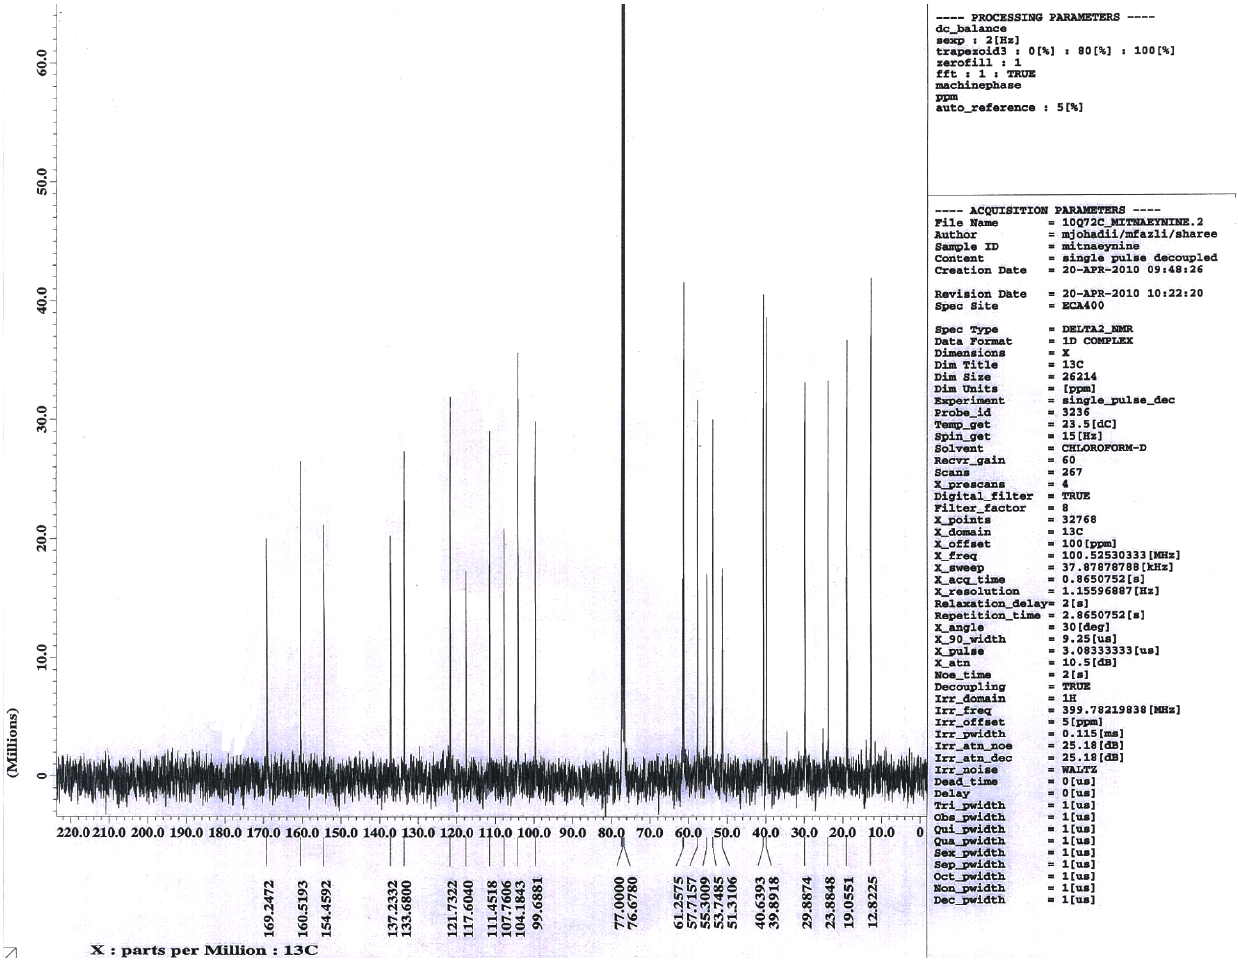
Figure 3. 13 C NMR chromatogram of mitragynine from Mitragyna speciosa leaves in deuterium